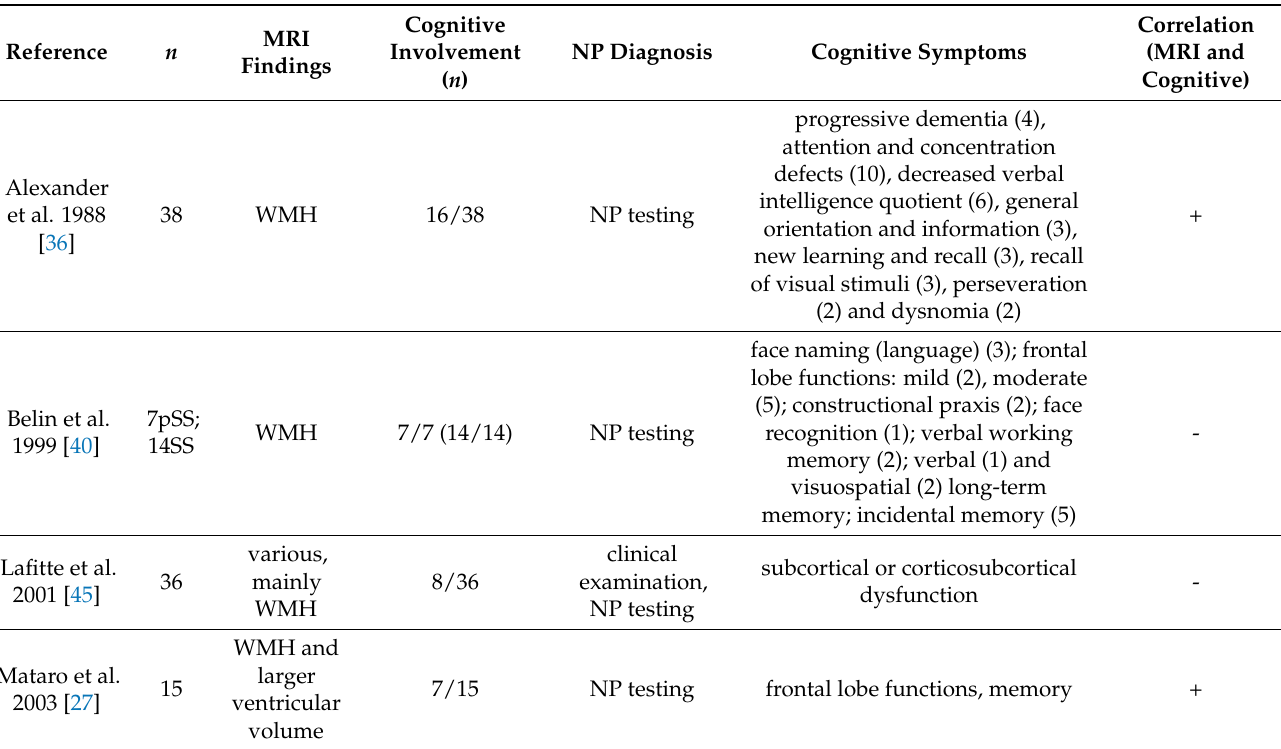
Table 2. MRI findings and cognitive functions in primary Sjögren’s syndrome. NP: